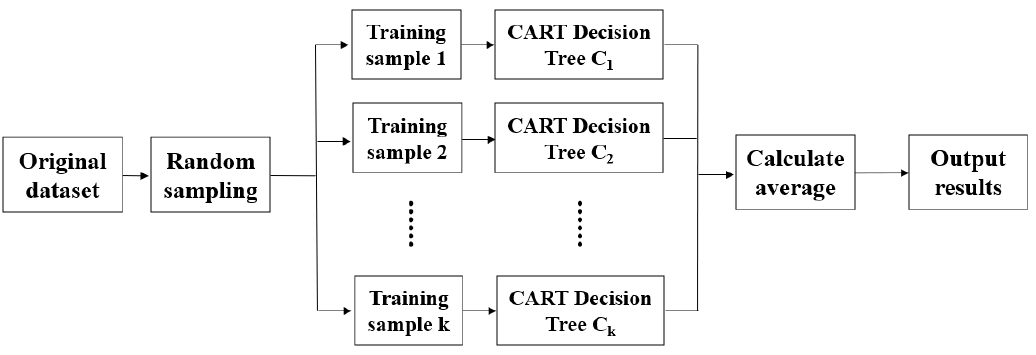
Figure 4. The training process of the random forest algorithm.